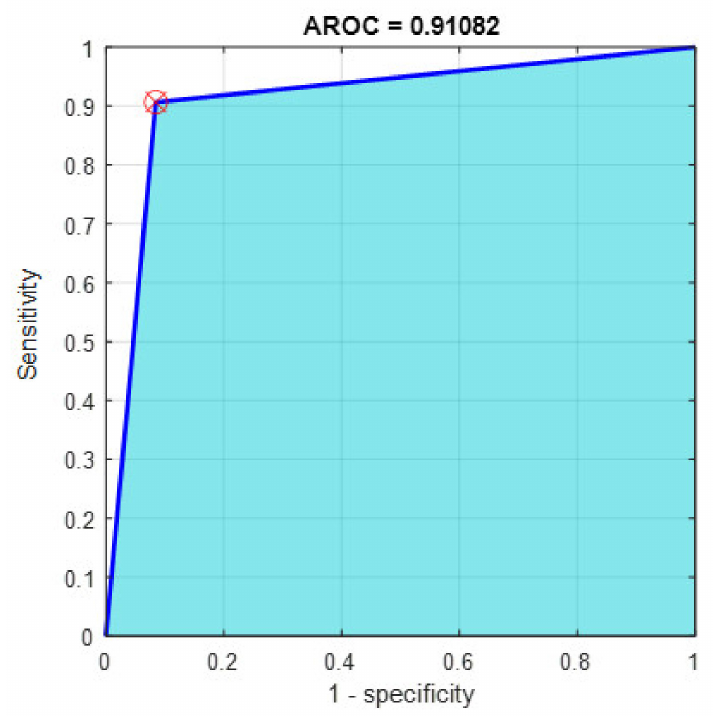
Figure 13. The AROC with ECFS-reduced features for Model